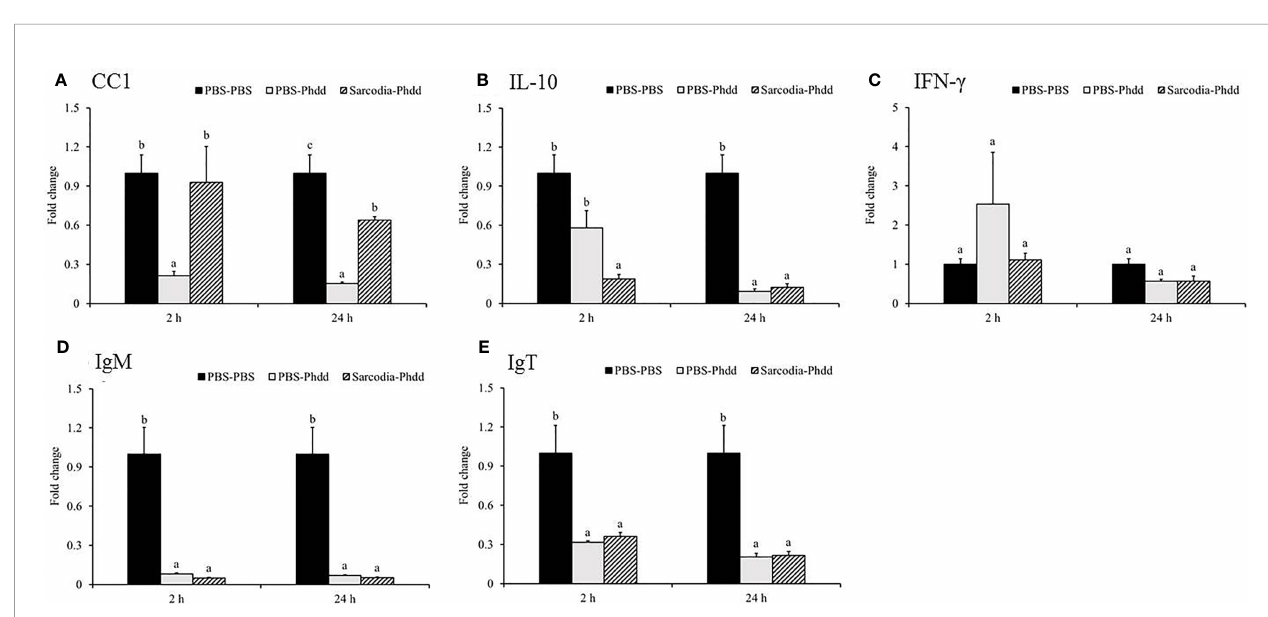
FIGURE 8 | Expression of immune genes in the head kidney (HK) tissue from fi sh intraperitoneal injected with PBS and Sarcodia suiae water extract after challenge with Photobacterium damselae subsp. damselae ( Phdd ). The relative expression pro fi le of (A) CC1 , (B) IL-10 , (C) IFN- g , (D) IgM , and (E) IgT in the HK samples was analyzed. The values are shown as mean + SEM (N = 3). Signi fi cant differences ( p < 0.05 ) are indicated by different